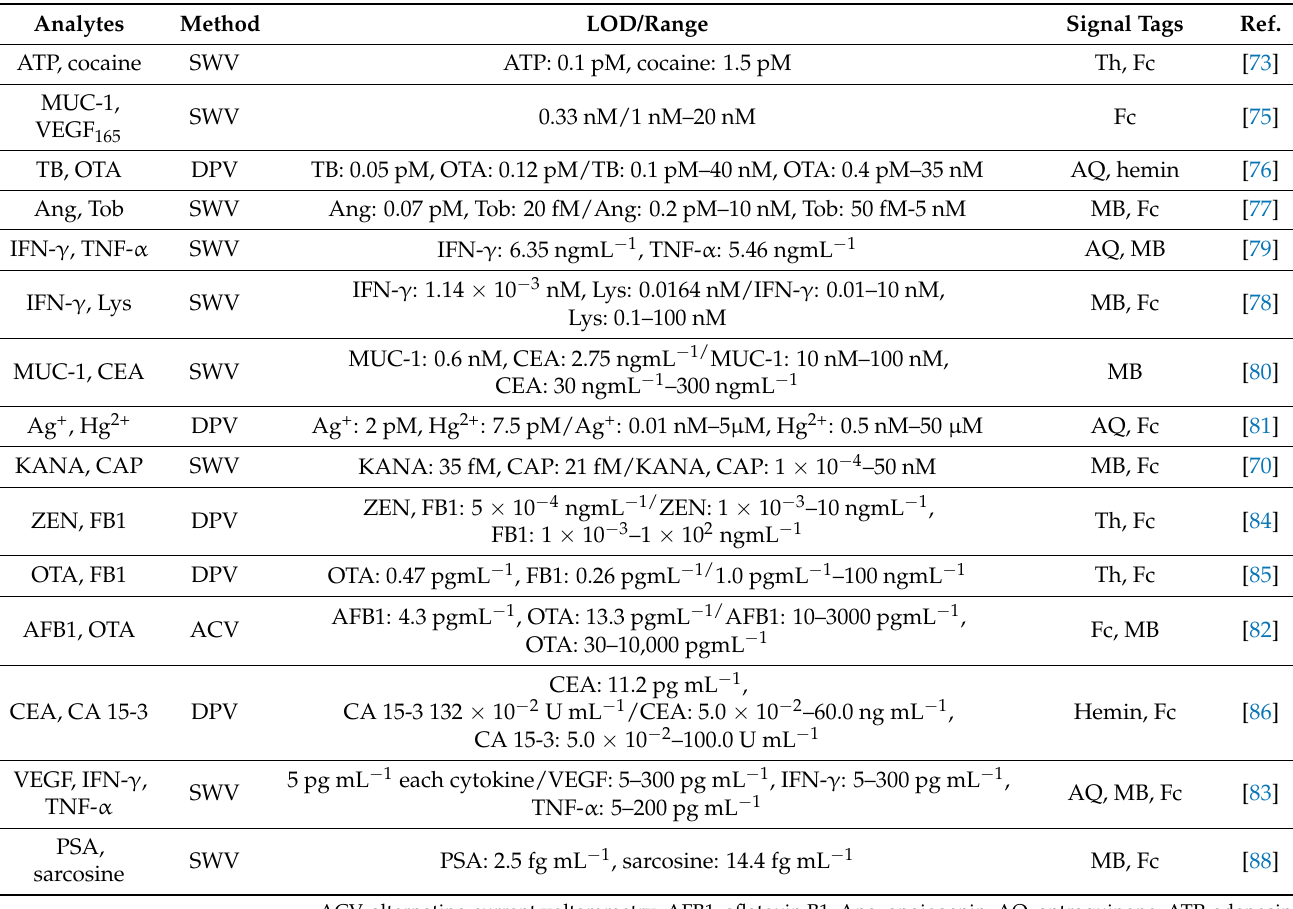
Table 2. Multiplex electrochemical aptasensors based on redox signal